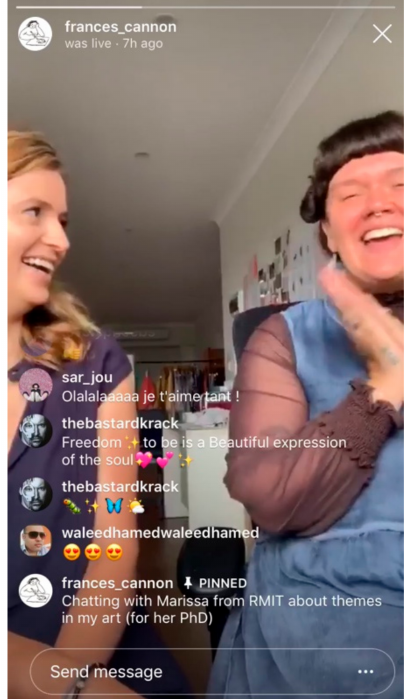
Figure 7. Intra-acting the interview. RMIT University Human Ethics Clearance Number